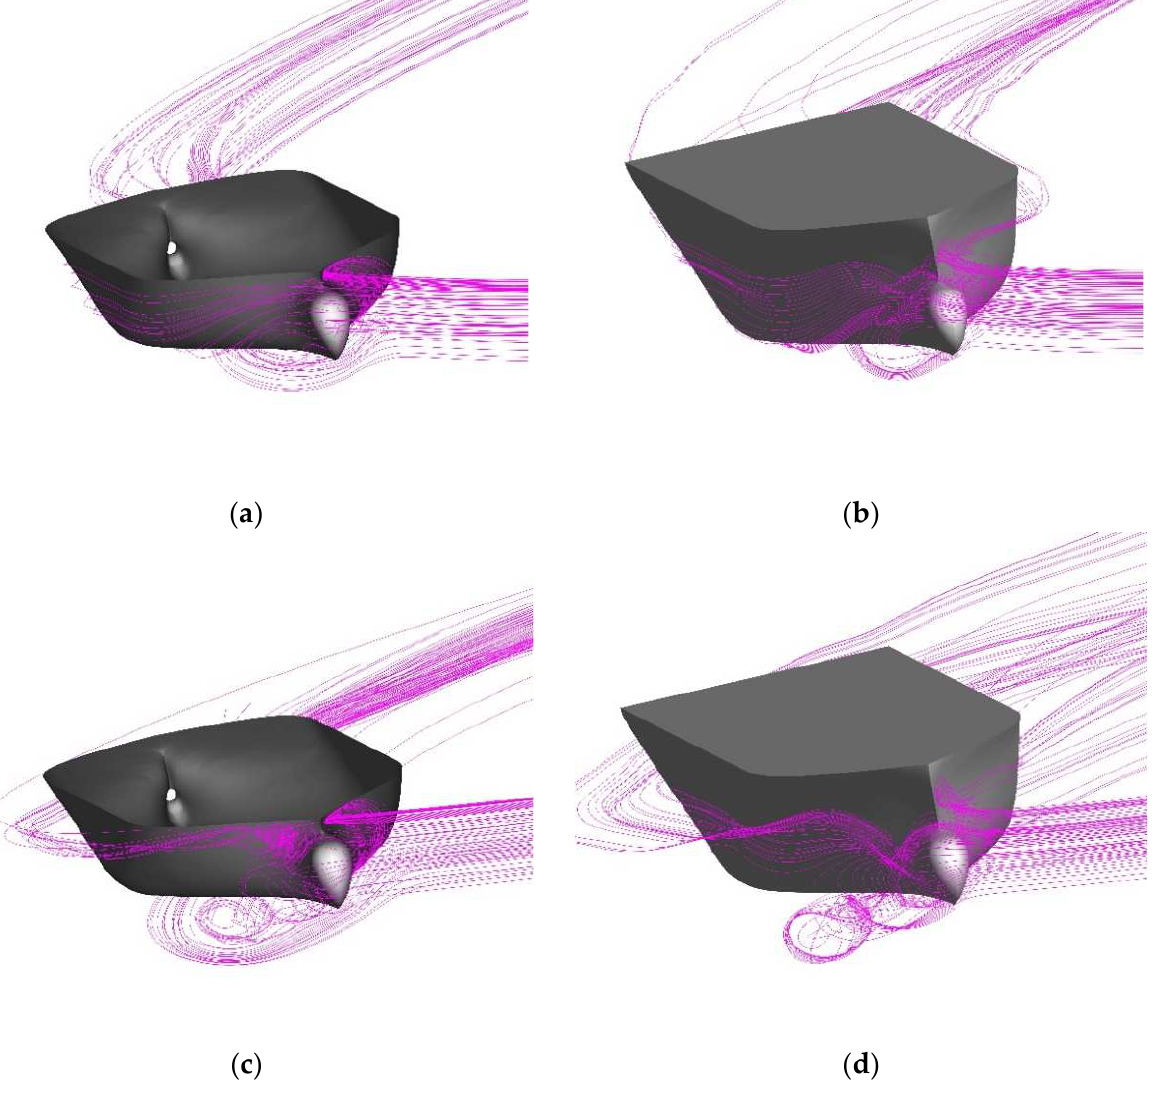
Figure 12. Streamlines around the hull for simulations of double-body flow ( left ) and water–air flow ( right ) for static circle motion. ( a ) Fr = 0.201, r (cid:48) = − 0.2. ( b ) Fr = 0.201, r (cid:48) = − 0.2. ( c ) Fr = 0.201, r (cid:48) = − 0.6. ( d ) Fr = 0.201, r (cid:48) = − 0.6.